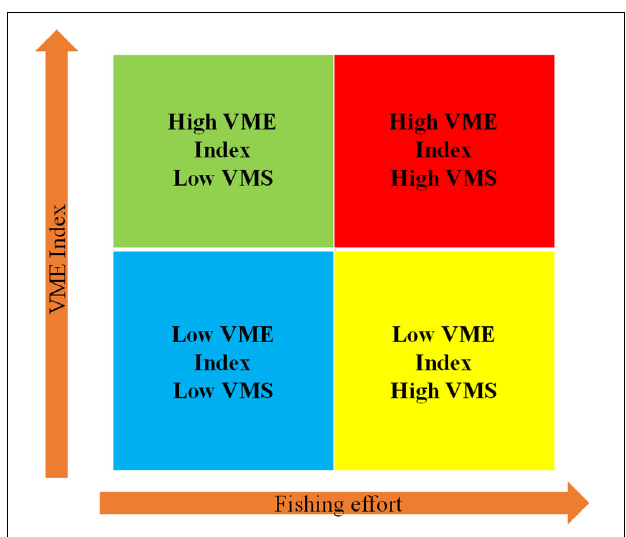
FIGURE 3 | Representation of the application of the portfolio categories concept.